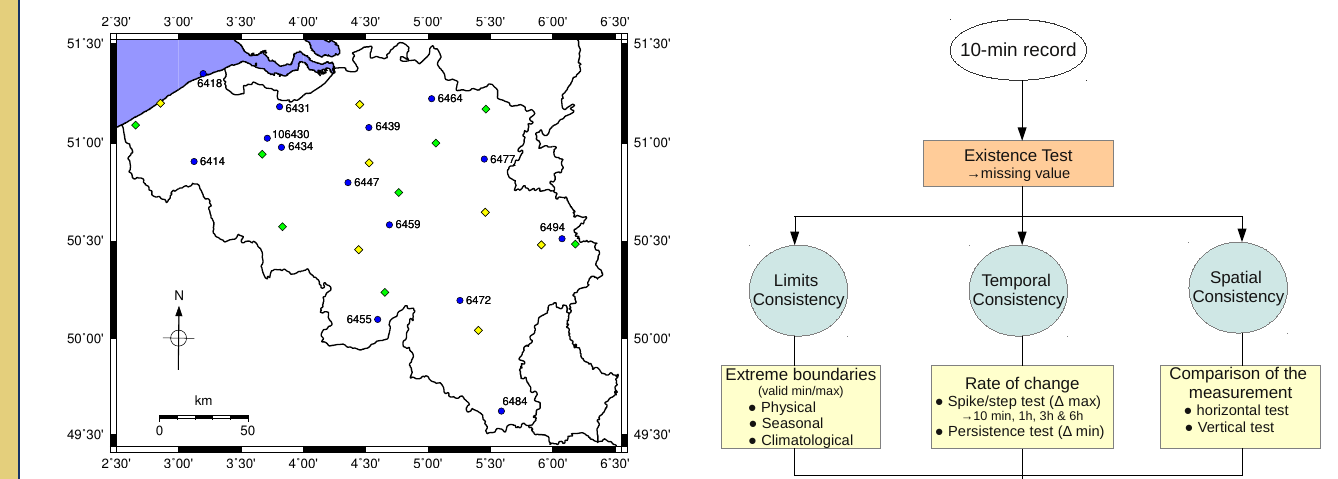
Figure 1. Location of the automatic air temperature measurements performed within the Belgian territory. Blue dots are for the RMI’s AWSs while yellows and green diamonds are for the Belgo-control and Meteo Wing AWSs. See Table 1 for the RMI’s stations names and associated air temperature records. Figure 2. Complex QA of 10-min air temperature records and de-